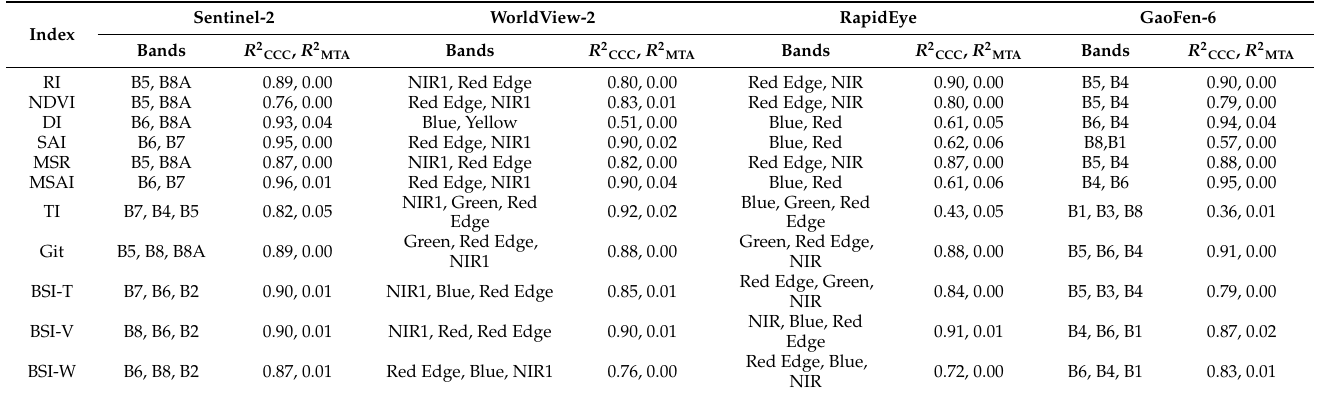
Table 6. Performance of the best new indices of each type for the four simulated satellite sensors in model